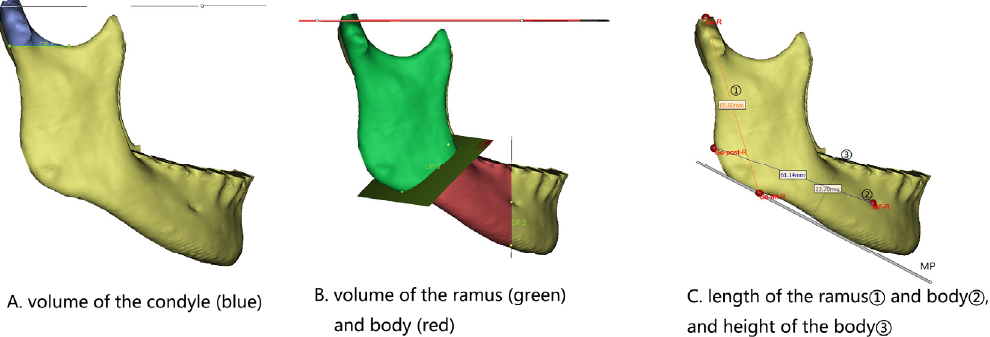
Figure 2. Morphological items evaluated in this study.